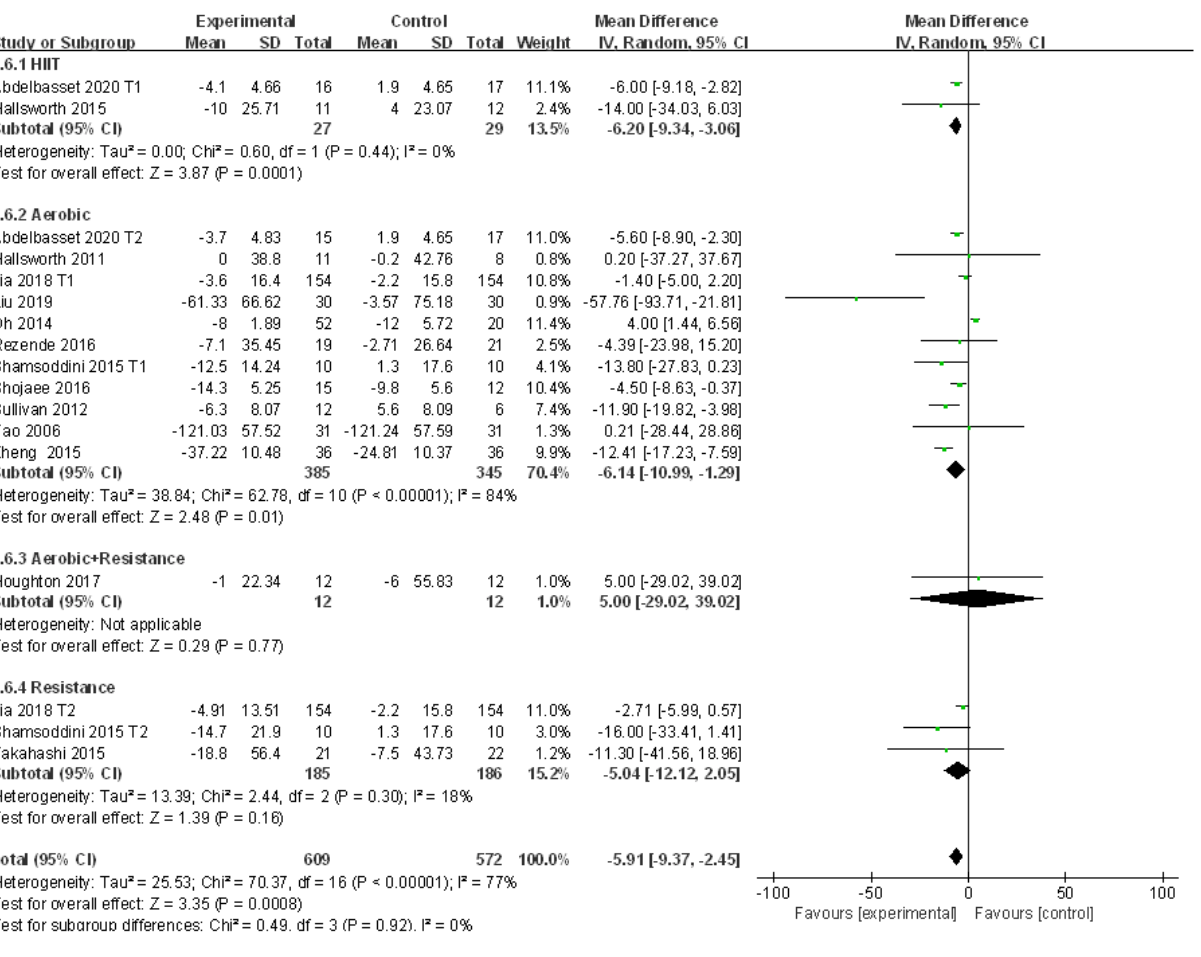
Figure 7. Subgroup analysis of different exercise styles on ALT.